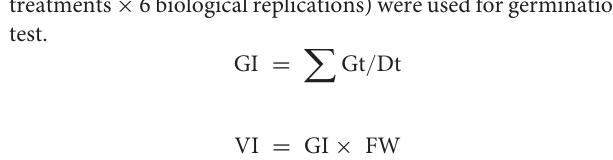
Frontiers in Plant Science |